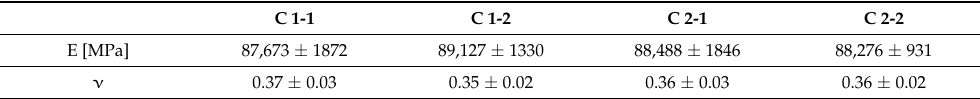
(cid:8) σ (cid:9) for each CSIRO HI for each CSIRO HI cell. xyz �𝜎𝜎 𝑥𝑥𝑥𝑥𝑥𝑥 �